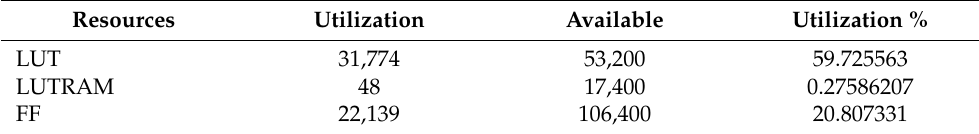
Table 9. Hardware resource consumption